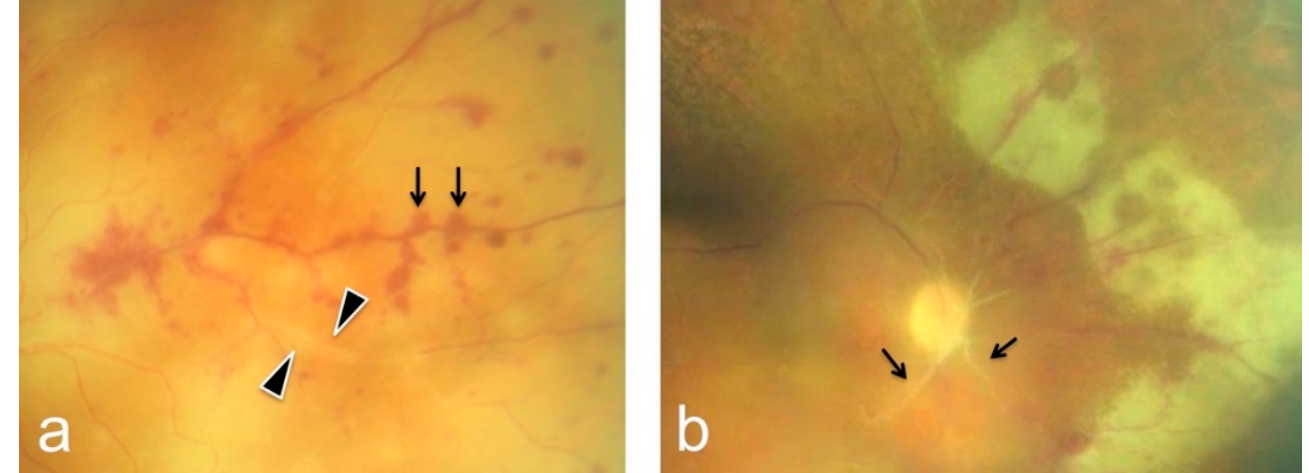
Figure 1. Findings in acute retinal necrosis with retinitis and perivascular infiltrations (arrowheads) as well as perivascular hemorrhage, whitish fundus, and retinal edema ( a ). ( b ) Parapapillary occlusive vasculitis, pale optic nerve disc, and peripheral retinal inflammation with secondary